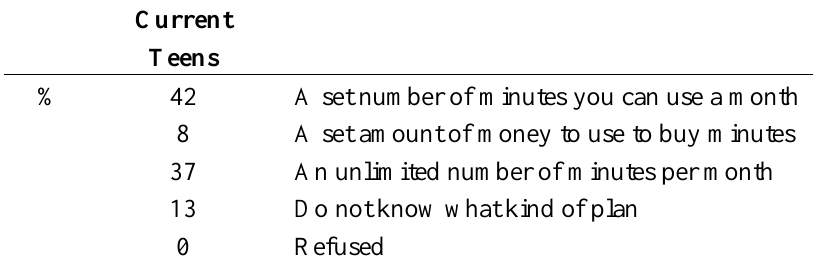
Table A7. Do you happen to know what kind of voice calling you have on your cell phone? Do you have a set number of minutes you can use a month; OR a set amount of money to use to buy minutes; OR an unlimited number of minutes per month? (Based on teen cell users [ N =